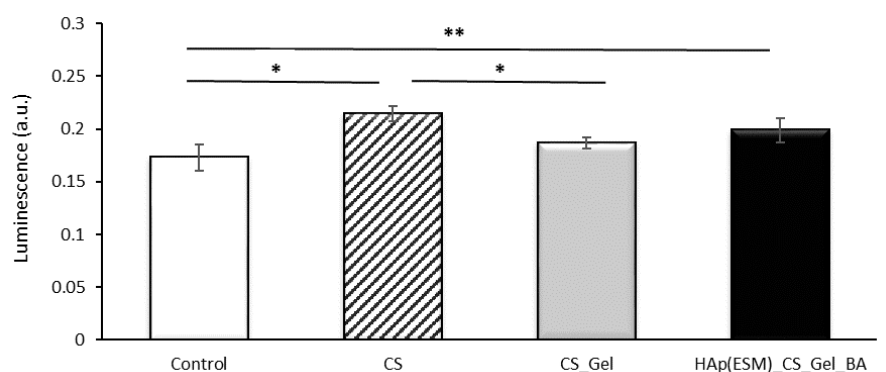
Figure 13. GSH analysis results after 24 h for the CS, CS_Gel and HAp(ESM)_CS_Gel_BA porous samples (presented as mean ± S.D. of 3 replicates); * means a value p < 0.005 Control versus CS and CS versus CS_Gel; ** means a value p < 0.05 Control versus HAp(ESM)_CS_Gel_BA.